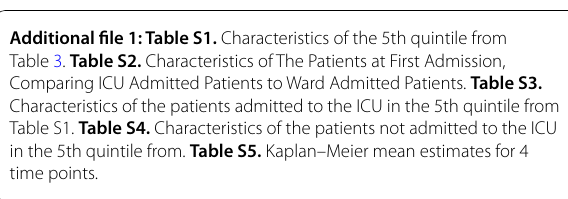
Table S1. Table S4. Characteristics of the patients not admitted to the ICU in the 5th quintile from. Table S5. Kaplan–Meier mean estimates for 4 time